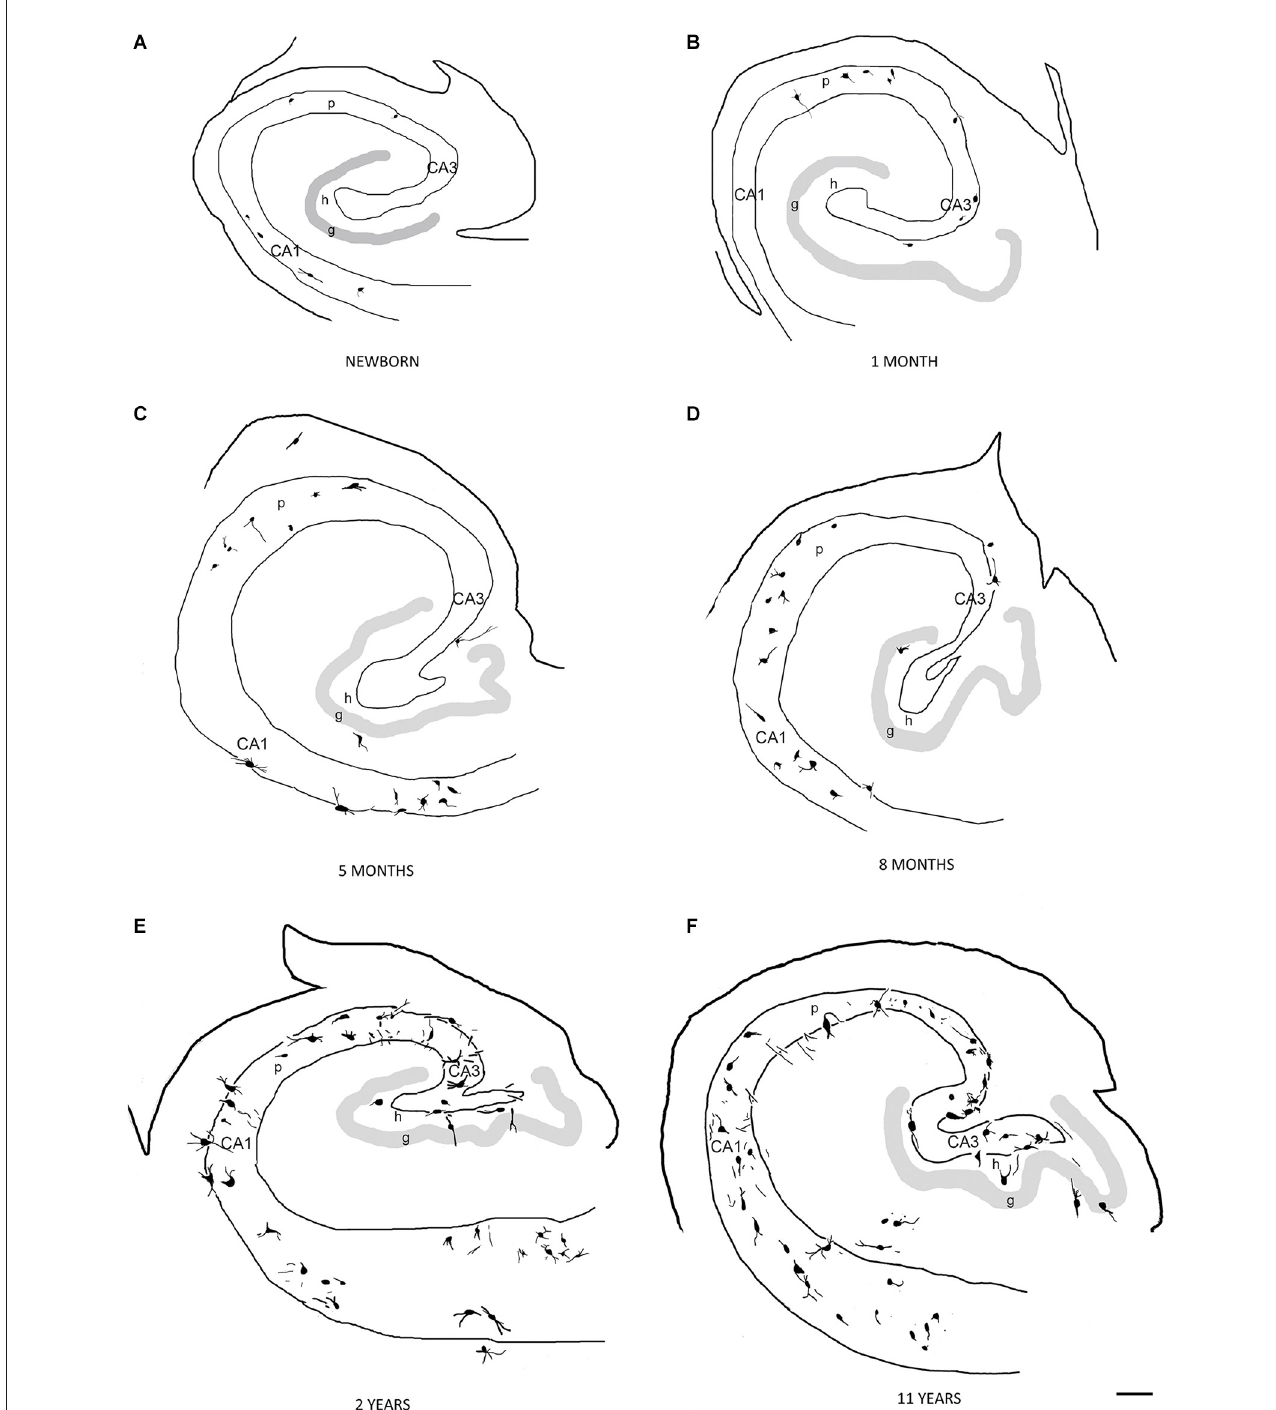
FIGURE2 Schematic drawing demonstrating the distribution of PV-immunoreactive neurons in the human hippocampal formation in a newborn (A) , in 1 month (B) , in 5 (C) , and 8 (D) months, in 2 (E) , and 11 (F) years old child. Scale bar = 500 µ m in (A–C) , 280 µ m in (D) and (E) , and 250 µ m in (F) . Abbreviations: g, granule cell layer; h, hilus of the dentate gyrus; p, pyramidal layer of CA1, CA3, regions of Ammon’s horn.